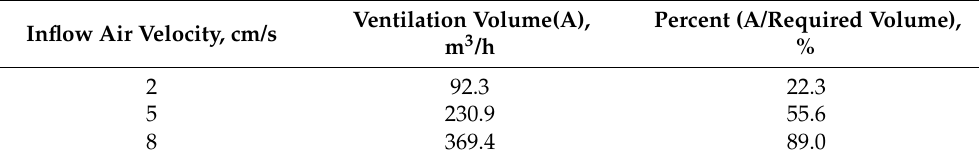
Table 5. Ventilation volume according to the inflow air velocities for three active soil filters in